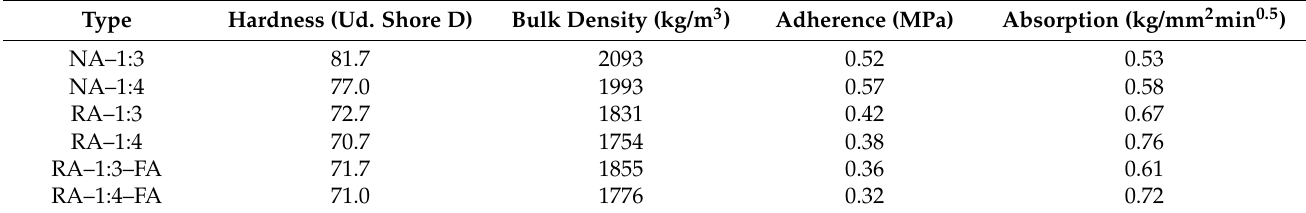
Table 10. Results of complementary physical characterization tests.